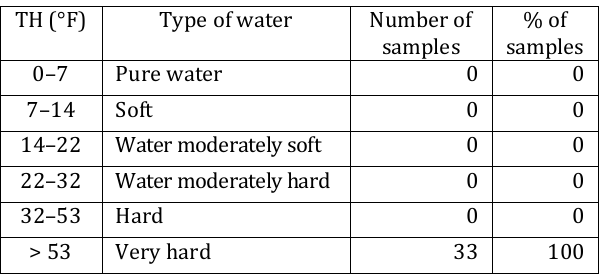
Table 4. Classification of groundwater for drinking based